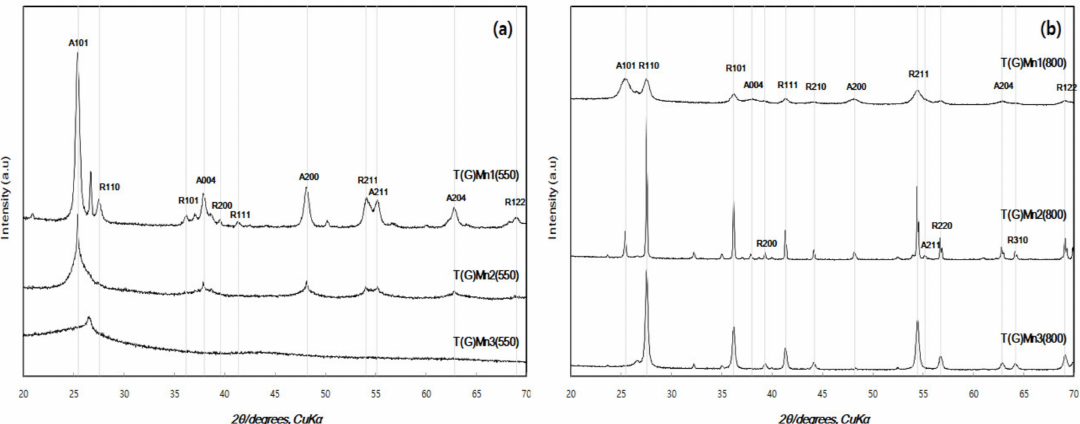
Figure 1. X-ray di ff raction patterns of (a) T(G–Mn1)(550) NW, T(G–Mn2)(550) NW, and T(G–Mn3)(550) NW; and (b) T(G–Mn1)(800) NW, T(G–Mn2)(800) NW, and T(G–Mn1)(800)